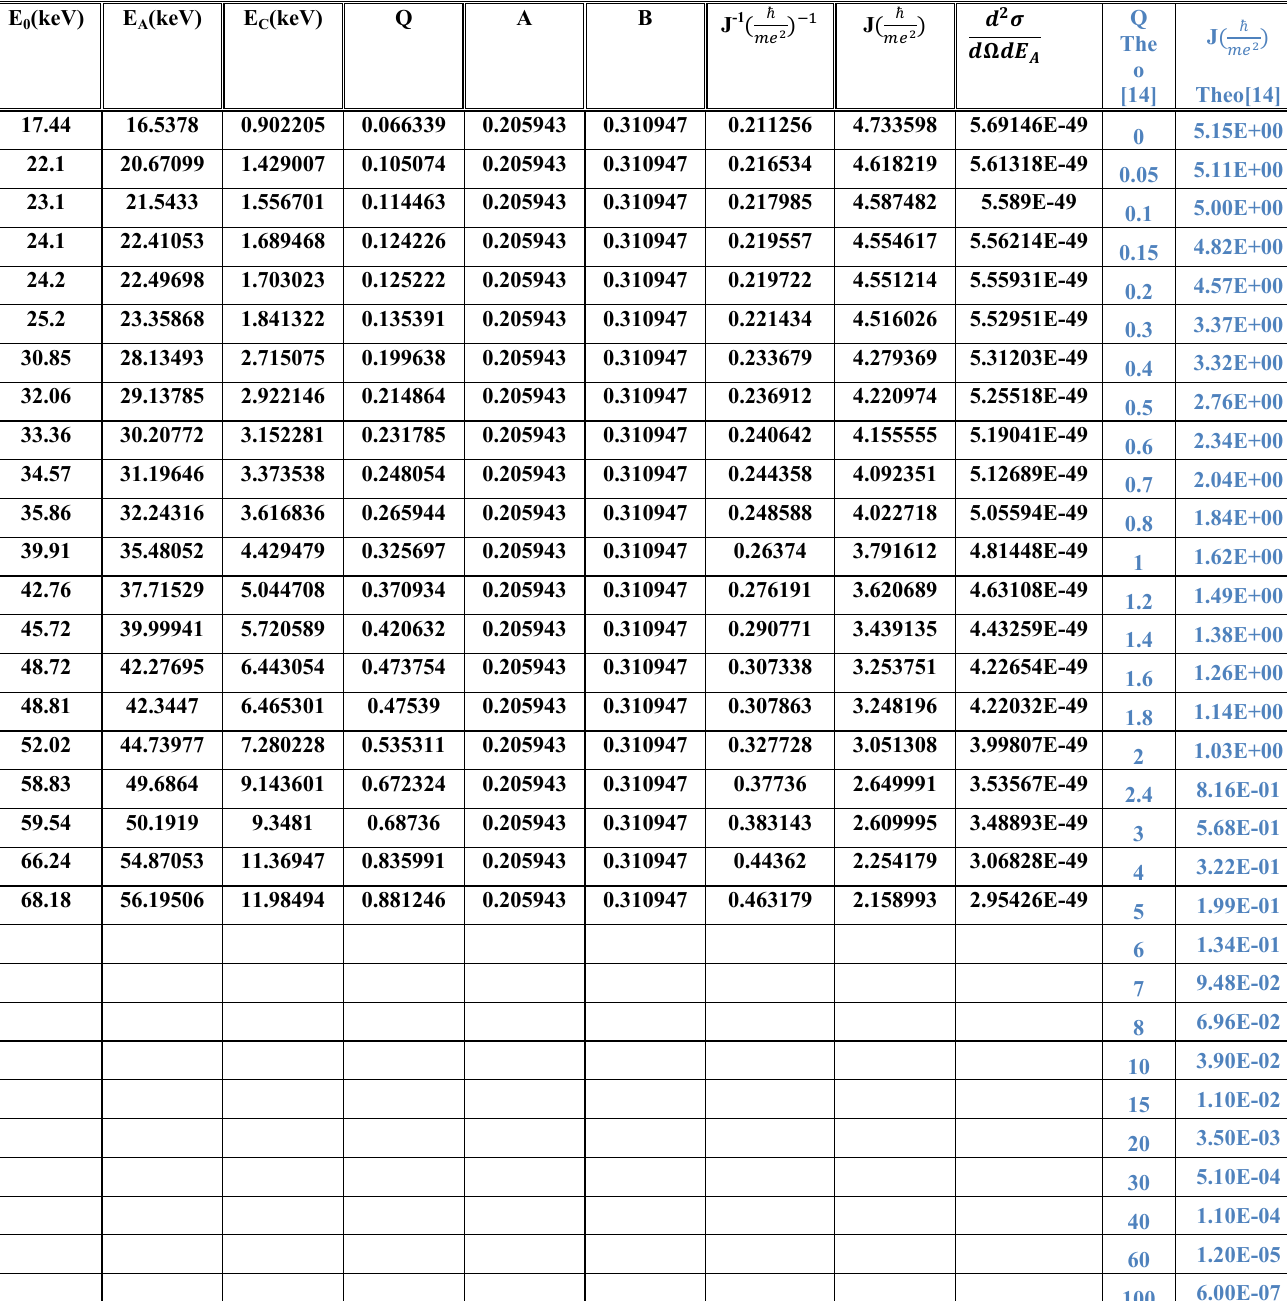
Table 5: The double-differential scattering cross section of Doppler broadening at angle (cid:2778)(cid:2785)(cid:2777) ° for